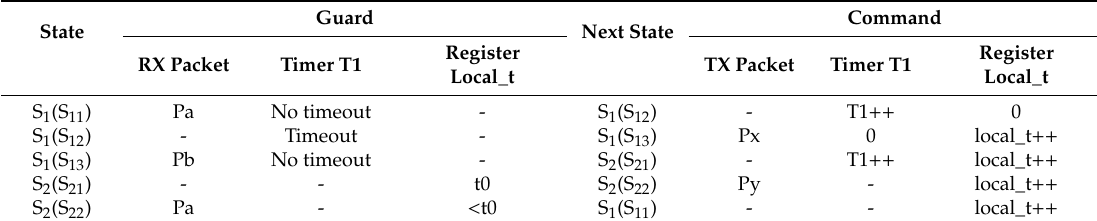
Figure 1. Example of a network protocol. Table 1. State transition table for the agent of host 2. The state transition table details the transition details of the control state